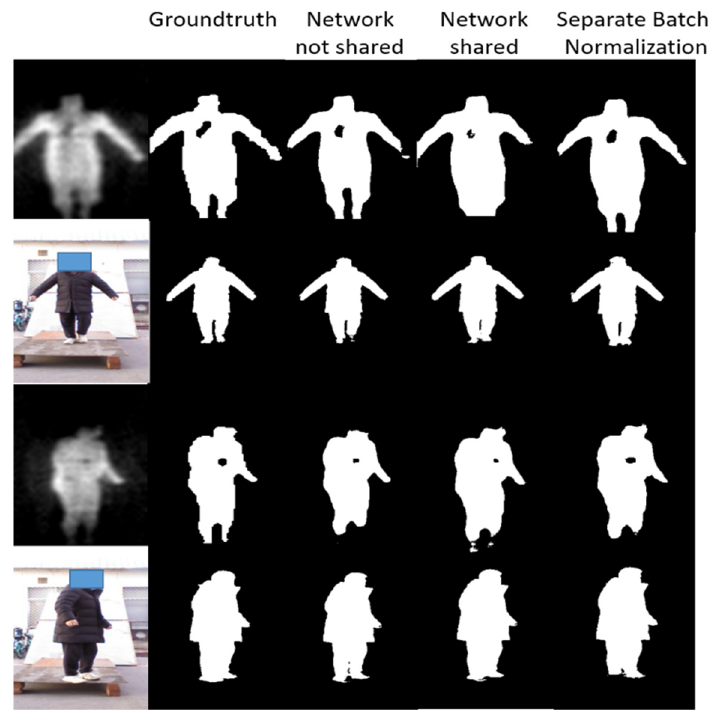
Figure 14. Experiment results of image segmentation. The first column consists of the raw VI and fused PMMWI, the second column is the corresponding groundtruth. The last three columns are the segment images under different networks. Table 3. Performance of Different Network Architectures.